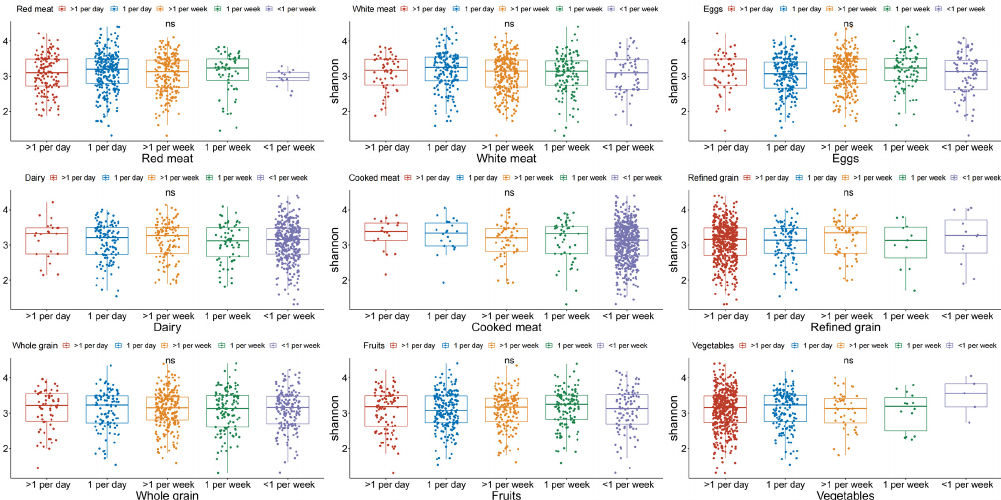
Figure 2. Boxplots for α -diversity Shannon index according to food intake frequencies in different food groups. ns: non-significant.